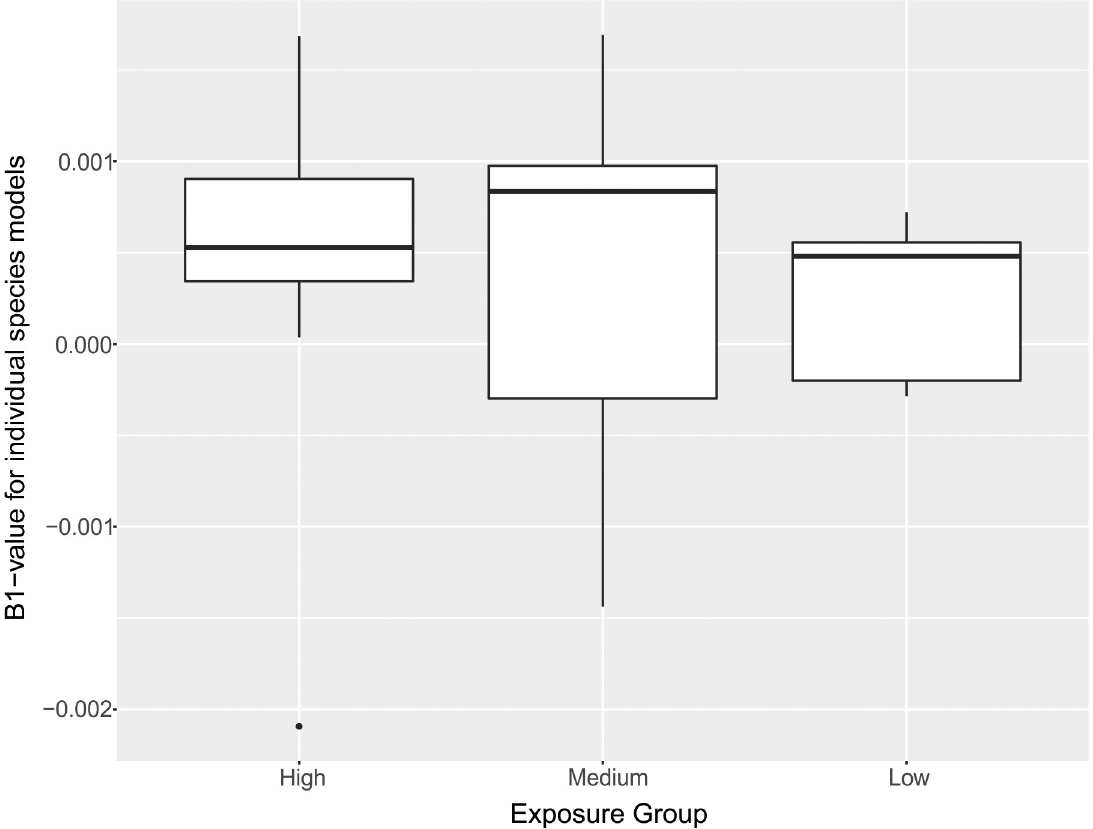
Fig 4. Distribution of β 1 values (change in species population growth per unit [TEF-adjusted kg] of NN applied) obtained for each species across dietary exposure groups. The mean is represented by the black lines through the centre of each bar, the upper and lower quartiles are contained within the box and the range is represented by the whiskers. The estimate for turtle dove ( Streptopelia turtur ) is displayed as an outlier (represented by the single point) for the high exposure group. TEF: toxicity equivalence